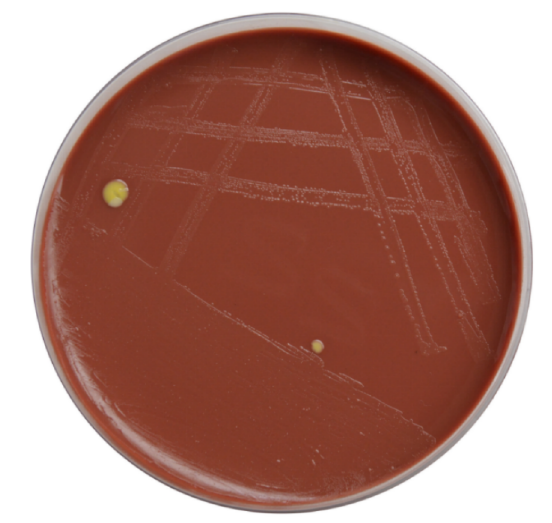
Figure 2: Brain heart infusion broth (BHIB) showing turbidity Figure 3: Growth on blood agar showing translucent, small near the surface compared to the control medium; note that 1 mm colonies with waxy Moraxella is an aerobic bacteria thus growth is near the surface.